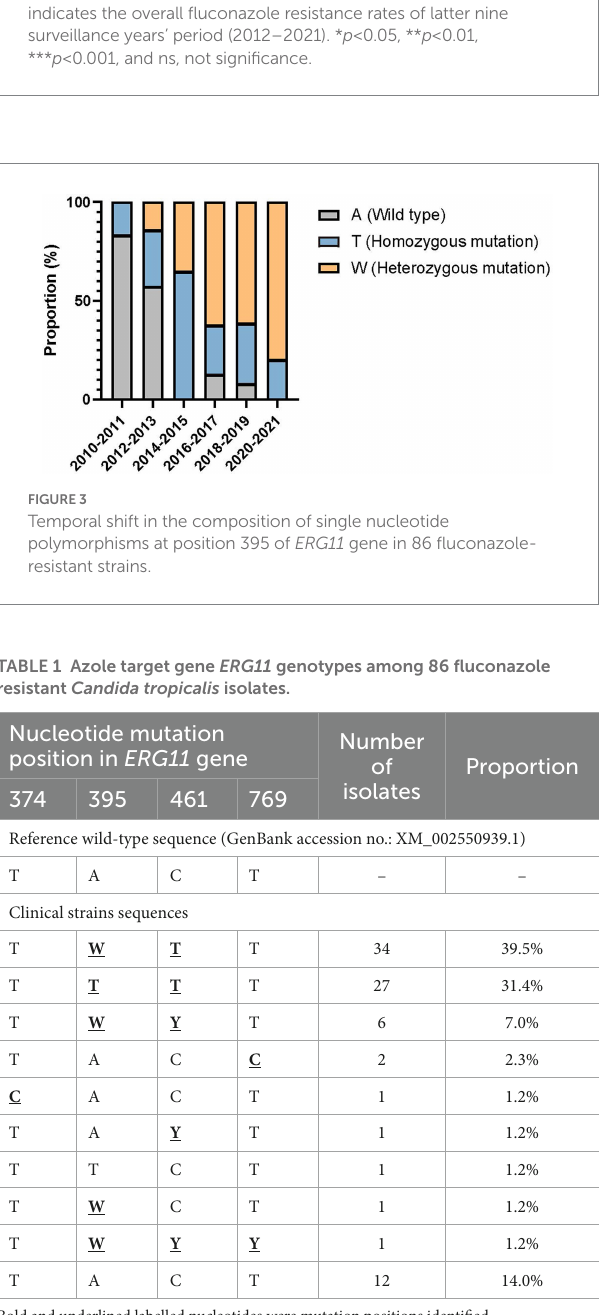
Bold and underlined labelled nucleotides were mutation positions identified.